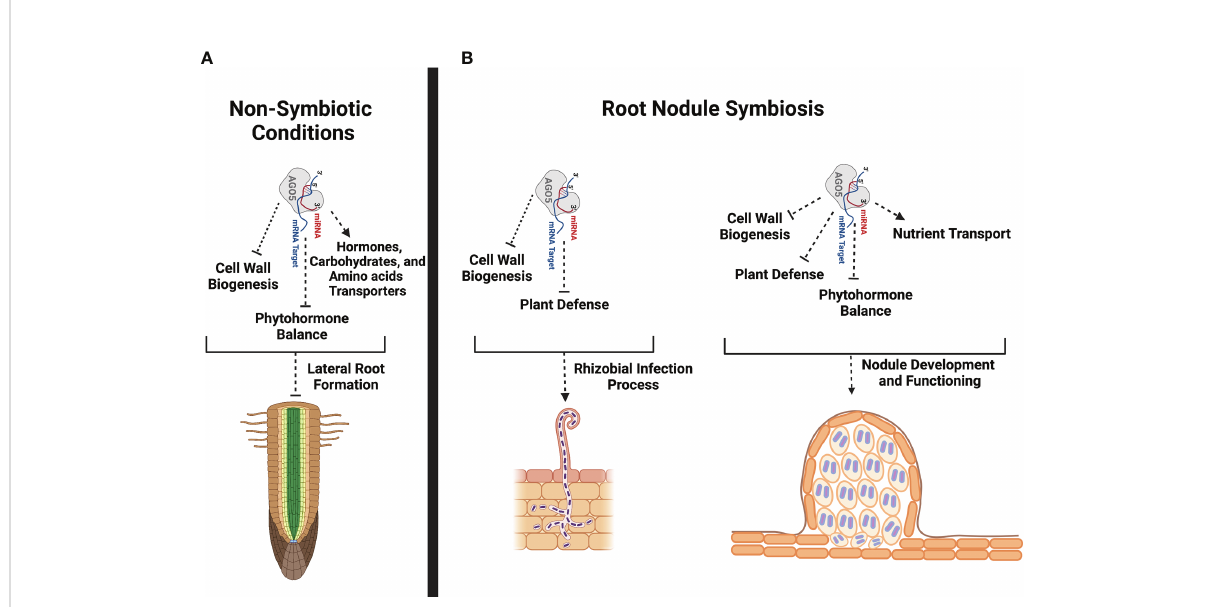
FIGURE 7 Schematic representation of potential PvAGO5 roles in lateral root formation and root nodule symbiosis. (A) Based on transcriptional data and phenotype from PvAGO5 -RNAi transgenic roots growing under non-symbiotic conditions, PvAGO5 might modulates the expression of genes involved in the cell wall biogenesis, phytohormone balance and transportation. Modulation of the expression of these genes may be required to control the number and density of lateral roots in P. vulgaris . (B) In contrast, AGO5 acts as a positive regulator of the root nodule symbiosis in P. vulgaris . PvAGO5 modulates the expression of genes participating in the fl avonoid biosynthesis, cell wall remodeling, and plant defense. It is likely that PvAGO5 participates in the cell wall remodeling, which is required to sustain the root hair curling that is crucial for rhizobial entrapping. Likewise, PvAGO5 may modulate the plant defense response to ensure the rhizobial infection and colonization. At late stages of this symbiosis, PvAGO5 may participate in cell wall remodeling and phytohormone balance allowing a proper nodule formation. Additional, PvAGO5 may also contribute to the nodule functioning by controlling the expression of nutrient transporter-encoding genes. Finally, it is likely that AGO5 also modulates the plant defense to host rhizobia during the nitrogen- fi xation process. This fi gure was created with